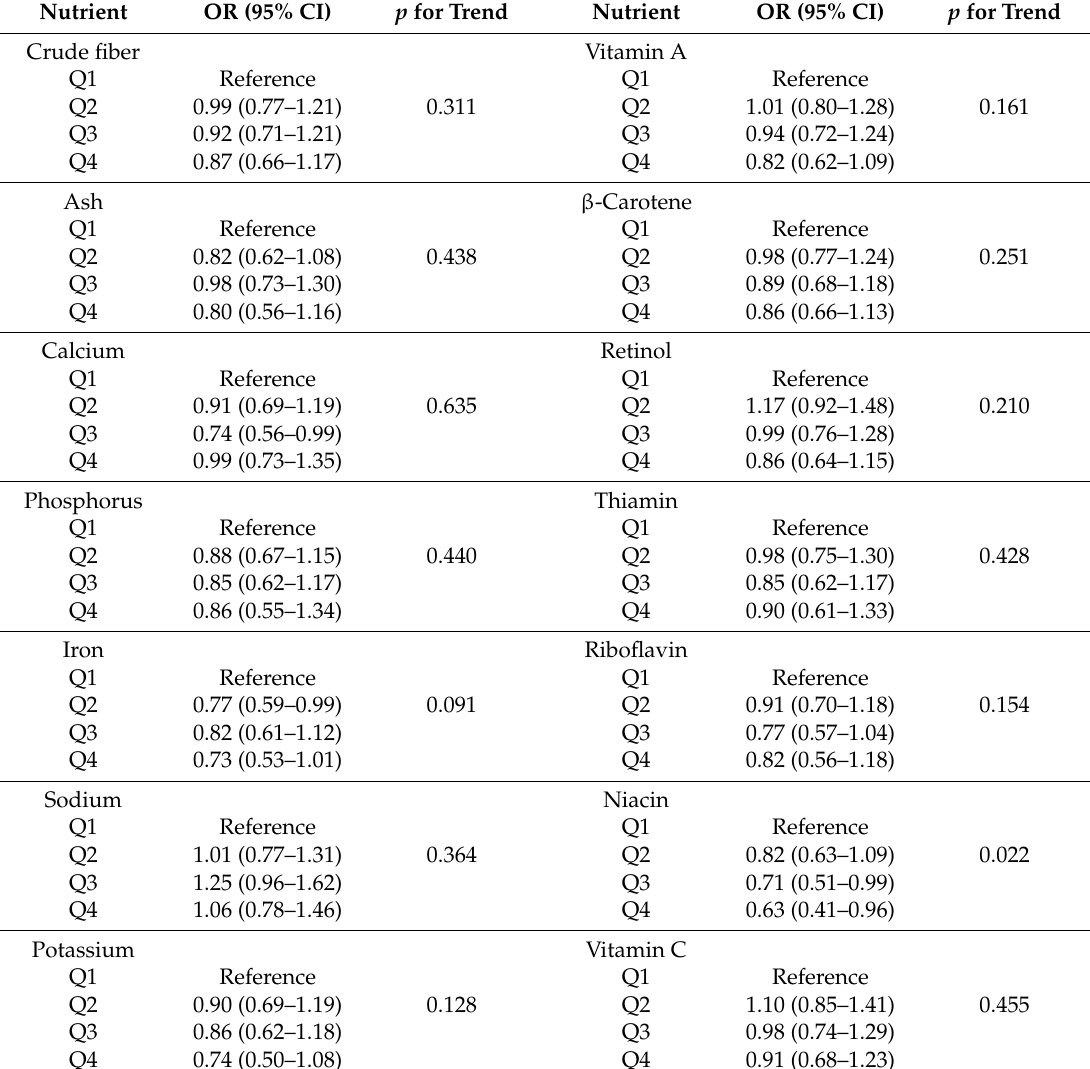
Table 6. Odds ratios of nutritional factors for glaucoma in subjects with intraocular pressure ≤ 21